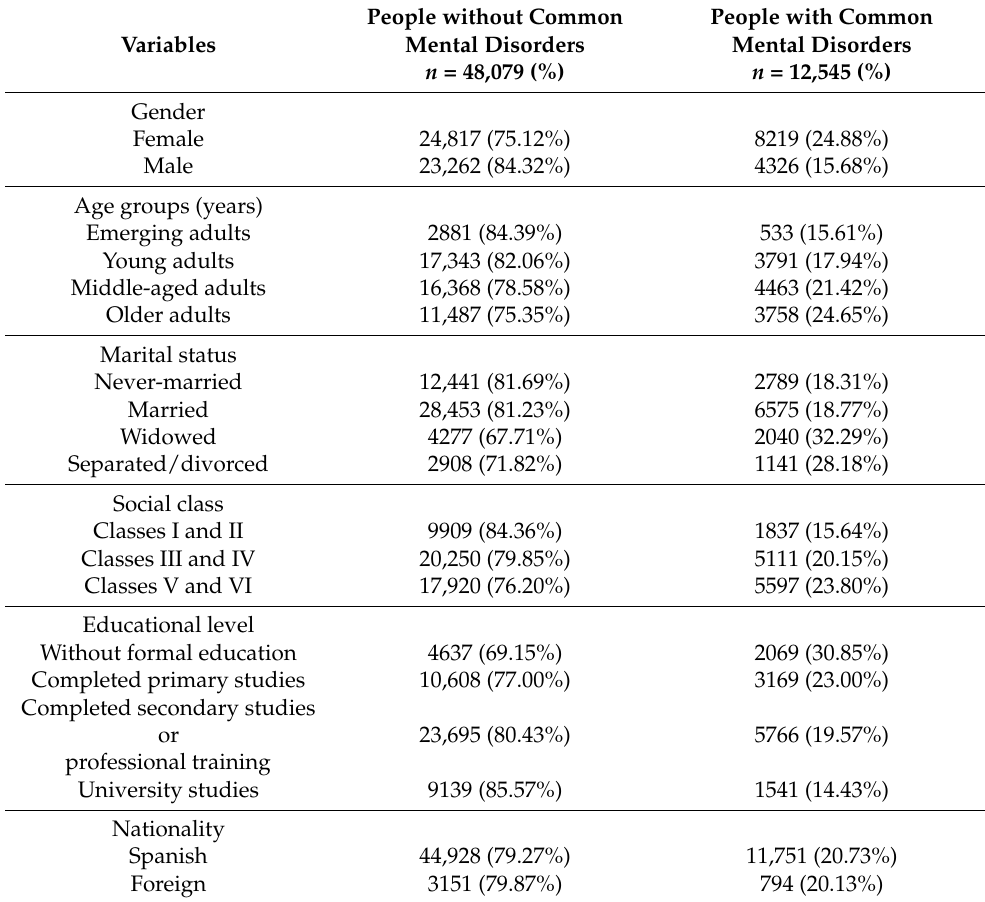
Table 1. Sociodemographic, lifestyle, and health-related characteristics of participants ( n = 60,624) (SNHS 2006, SNHS 2011/12 and SNHS